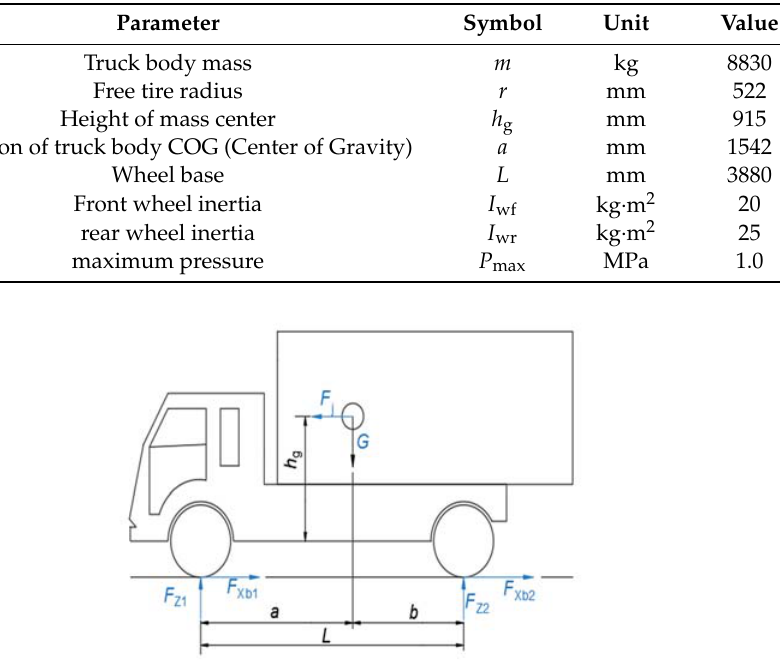
Table 4. Initial parameters of simulation.